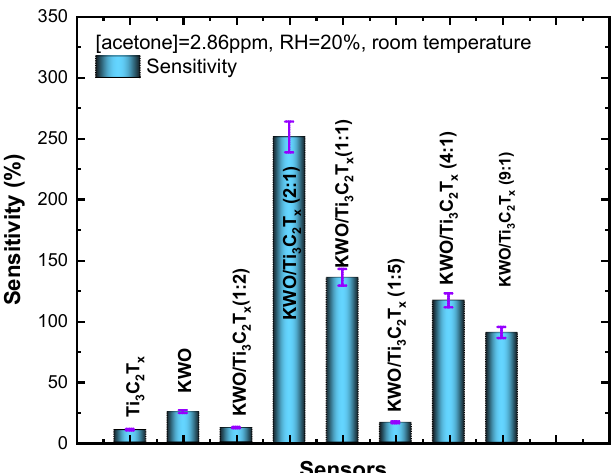
Figure 4. Sensing test on 2.86 ppm acetone at room temperature, RH = 20% using variable sensors based on Ti 3 C 2 T x nanosheets, KWO nanorods, KWO/Ti 3 C 2 Tx (1:2), KWO/Ti 3 C 2 T x (2:1), KWO/Ti 3 C 2 T x (1:1), KWO/Ti 3 C 2 T x (1:5), KWO/Ti 3 C 2 T x (4:1), and KWO/Ti 3 C 2 T x (9:1).